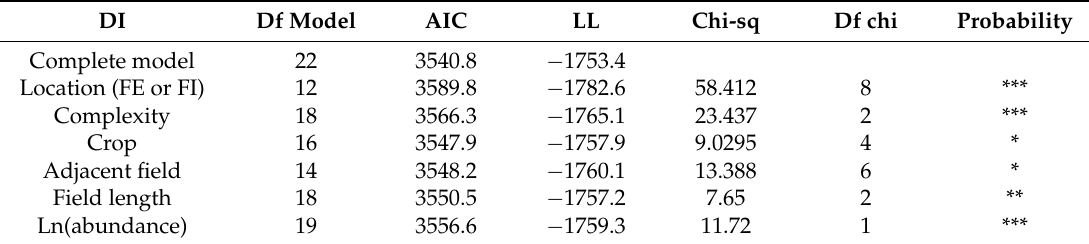
Table 9. The best fitting model for DI (Model 1000, Table 4; model estimates in Table S4d–f). Variables included Location (FE or FI), Complexity at 1000 m, crop in the FI (soybean or corn), closest adjacent field (soybean, corn, grassland or developed), area of FI (ha), width of the FE (m), length of the FE (m), and sample size (ln abundance). Df: degrees of freedom; AIC: Akaike information criterion, LL: Log Likelihood: Chi-sq: Chi-square. The importance of the separate fixed factors were tested with a